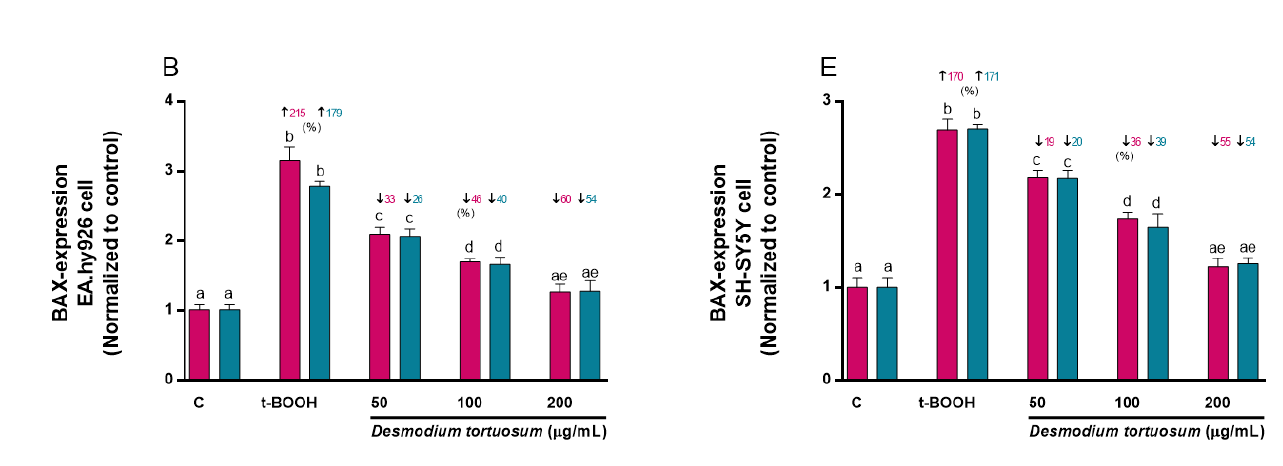
Figure 2. Antioxidant effects by D. tortuosum extract on ROS production induced by t-BOOH in EA.hy926 ( A ) and SH-SY5Y ( B ) cells after co-treatment (red bars, █ ) and pre-treatment (blue bars, █ ) periods. ROS production was measured as fluorescence units. Data are presented as mean ± SEM of six independent experiments. a,b,c,d,e,f Different letters show significance between groups at p < 0.05. ↑ represents percentage increase with respect to control, ↓ represents percentage decrease with respect to t-BOOH.